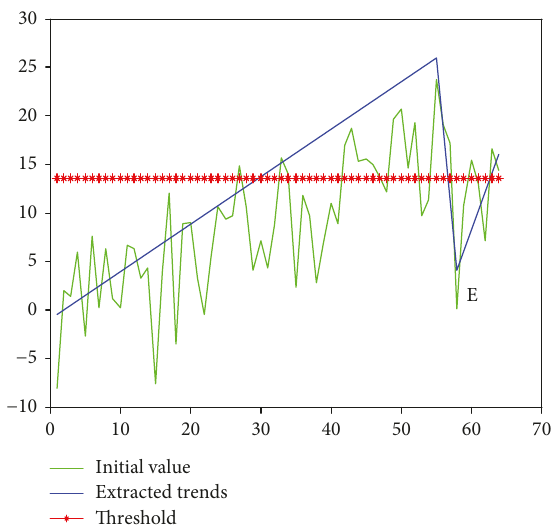
Figure 11: Initial value and extracted trends of T